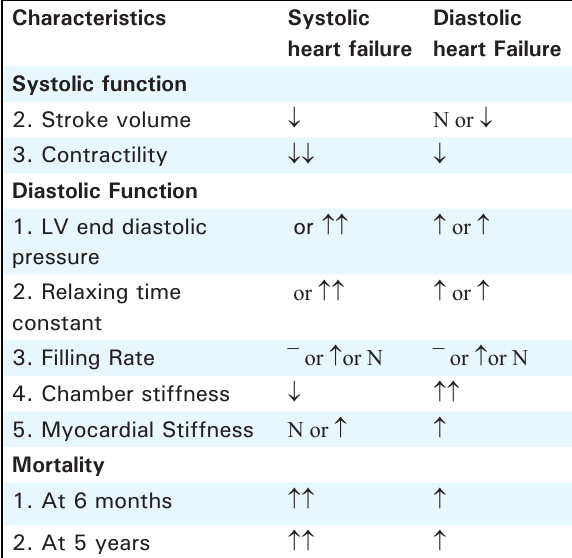
Table 1. Characteristics of Systolic Vs Diastolic Heart